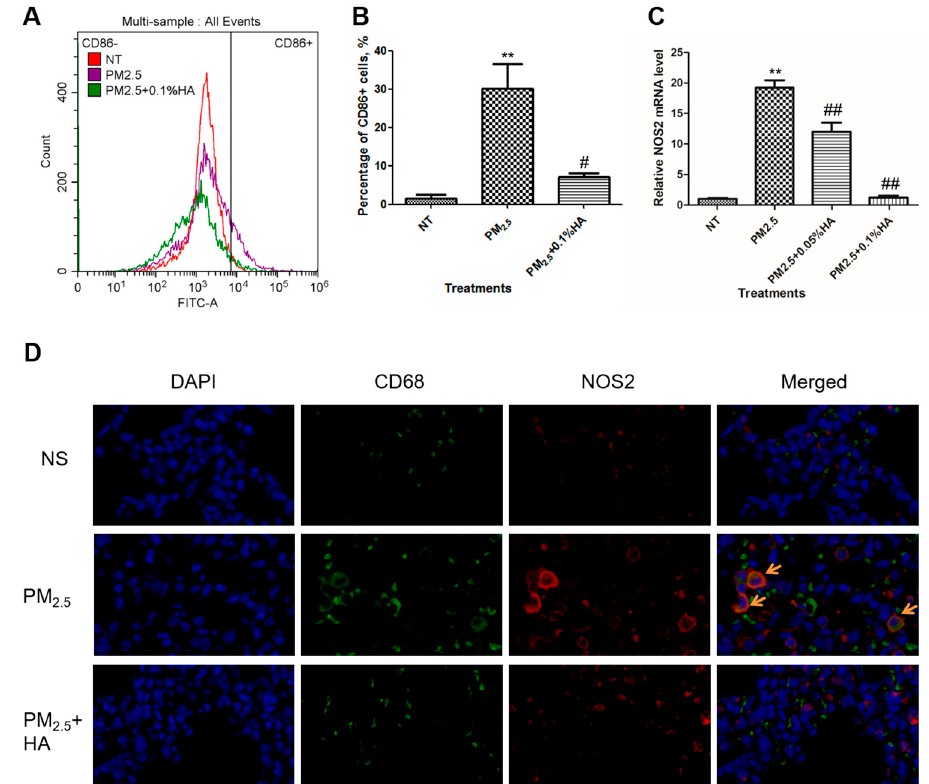
Figure 3. Inhibitory effects of HMW-HA on PM 2.5 -induced M1 polarization. ( A ) NR8383 cells were administered with PBS, PM 2.5 , or PM 2.5 and HMW-HA simultaneously for 24 h, and CD86 (M1 marker) protein expression level was determined by flow cytometry. ( B ) The percentage of CD86-positive cells was calculated. Data were presented as mean ± SEM of three independent experiments. ( C ) The mRNA level of NOS2 (M1 marker) was determined by real-time RT-PCR after NR8383 cells were treated as indicated for 6 h. Data are presented as mean ± SD, and represent three independent experiments. ** p < 0.01, compared with the NT group. # p < 0.05 and ## p < 0.01, compared with cells exposed to PM 2.5 alone. ( D ) Rats were exposed to NS, PM 2.5 or PM 2.5 +0.2% HA for three consecutive days by intratracheal instillation. Lung tissues were counterstained with anti-CD68 (macrophage marker, green) and anti-NOS2 (M1 marker, red) antibodies, and nuclei were stained with DAPI (blue). Fluorescence was observed by fluorescence microscopy. Arrows indicate M1 macrophages.